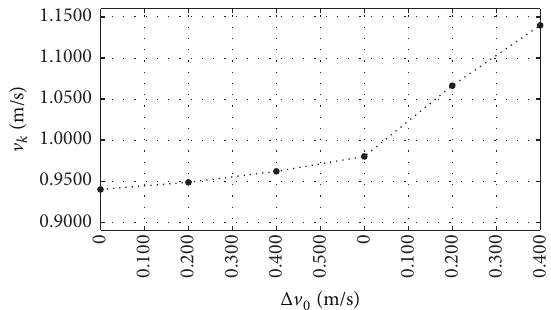
Figure 6: Characteristic of flow velocity at Katulampa with respect to uniform increasing of initial flow speed of all regions.